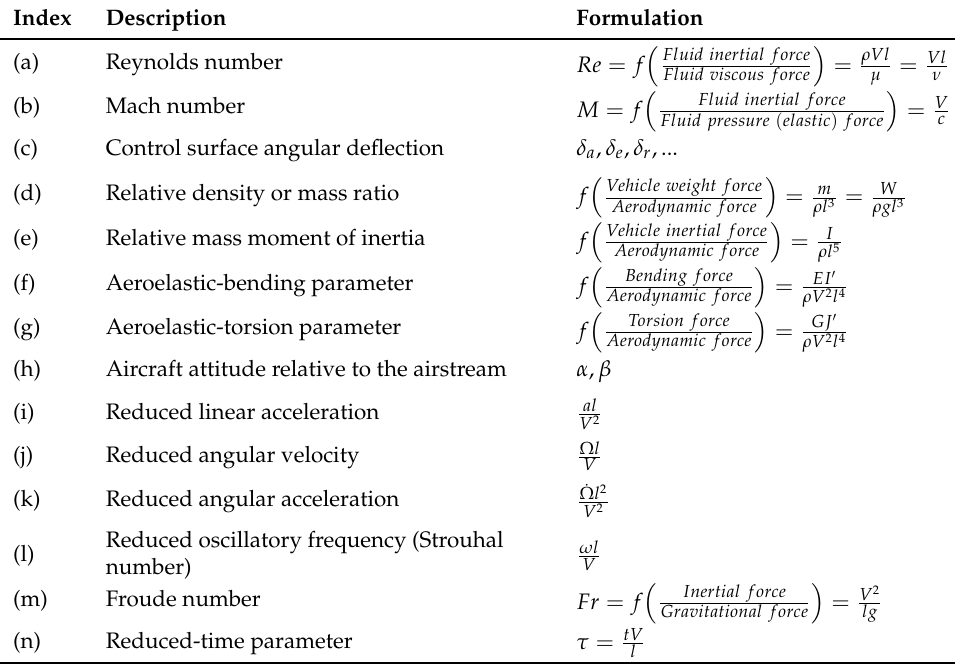
Table 1. Description of the similarity parameters found in Equation (3).